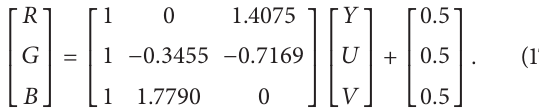
Figure 2: Diff(PSNR) with the similarity in 𝑌 , 𝑈 , and 𝑉